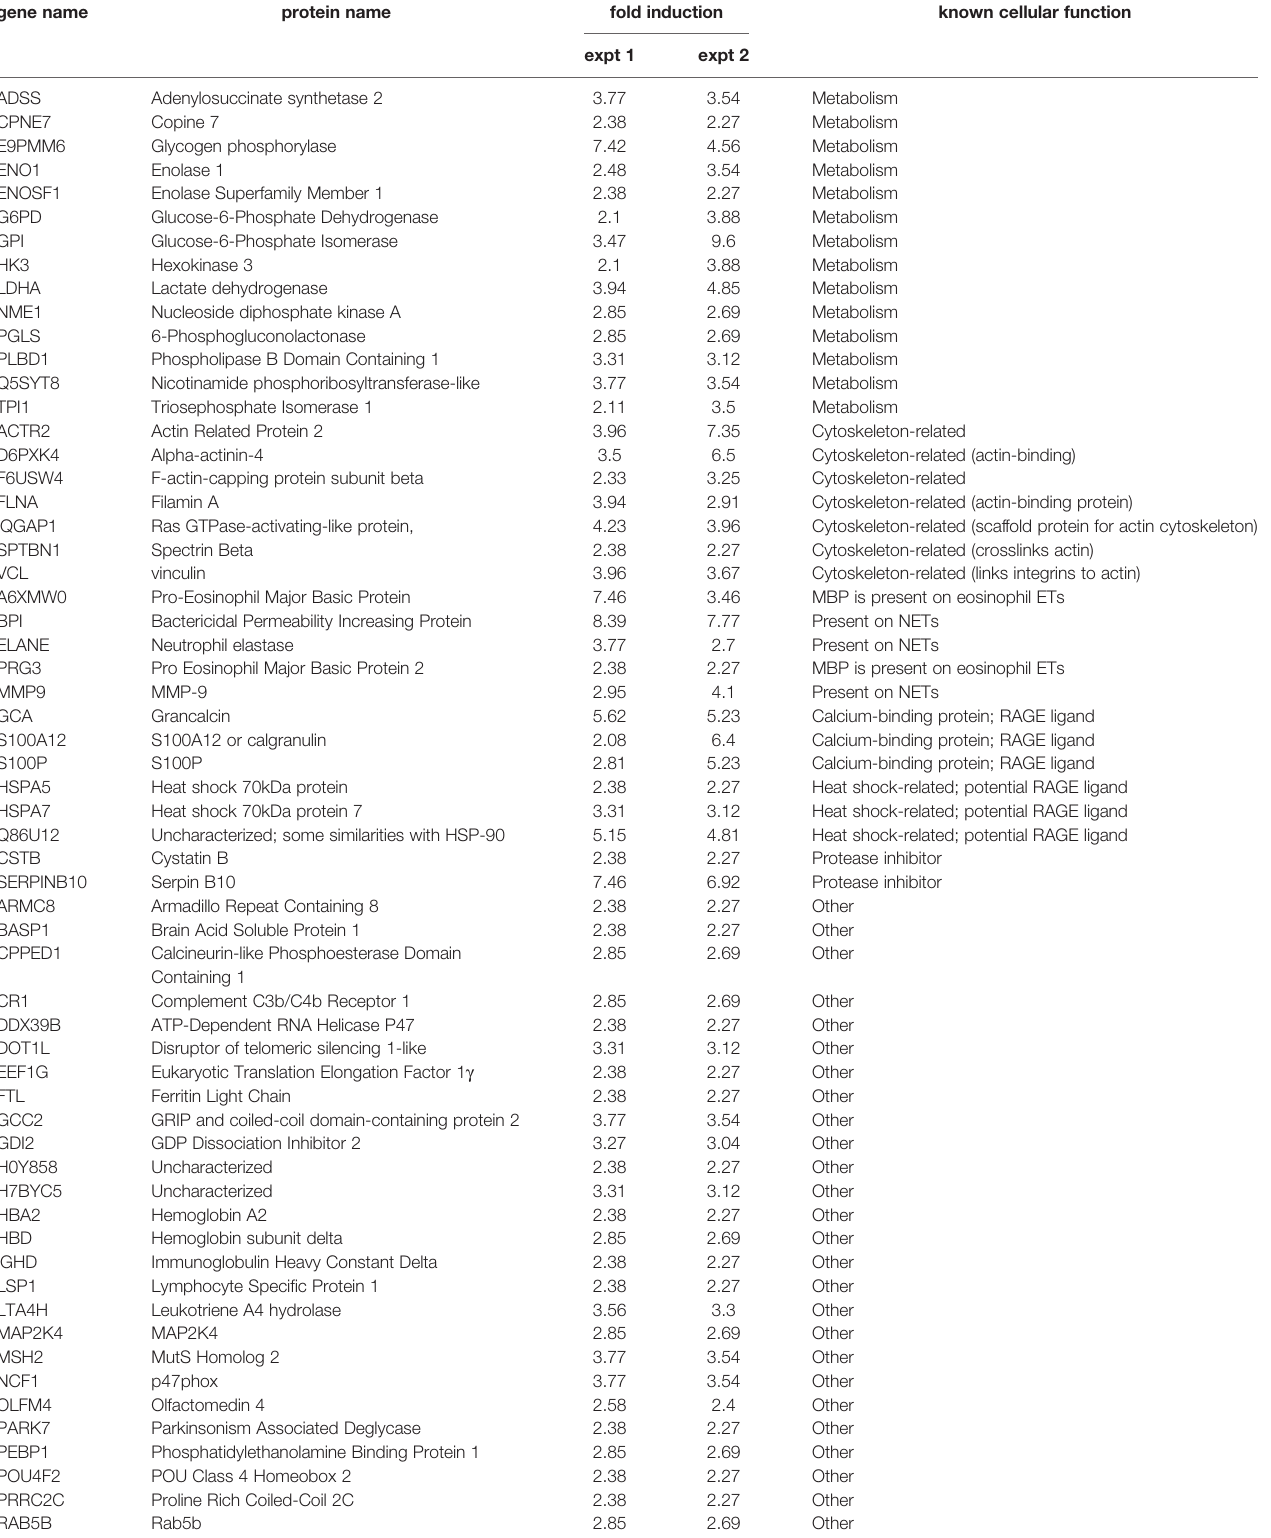
TABLE 2 | Common proteins featuring featuring at least a 2-fold induction (neutrophils unstimulated for 3h vs for 30 min), in two independent experiments. gene